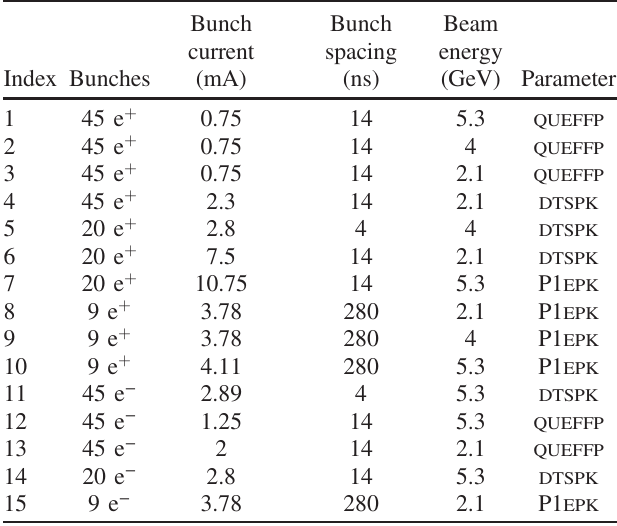
TABLE V. Summary of relevant POSINST parameters. The last column indicates whether the parameter was used in fits always (A), in some cases (S), or never (N).